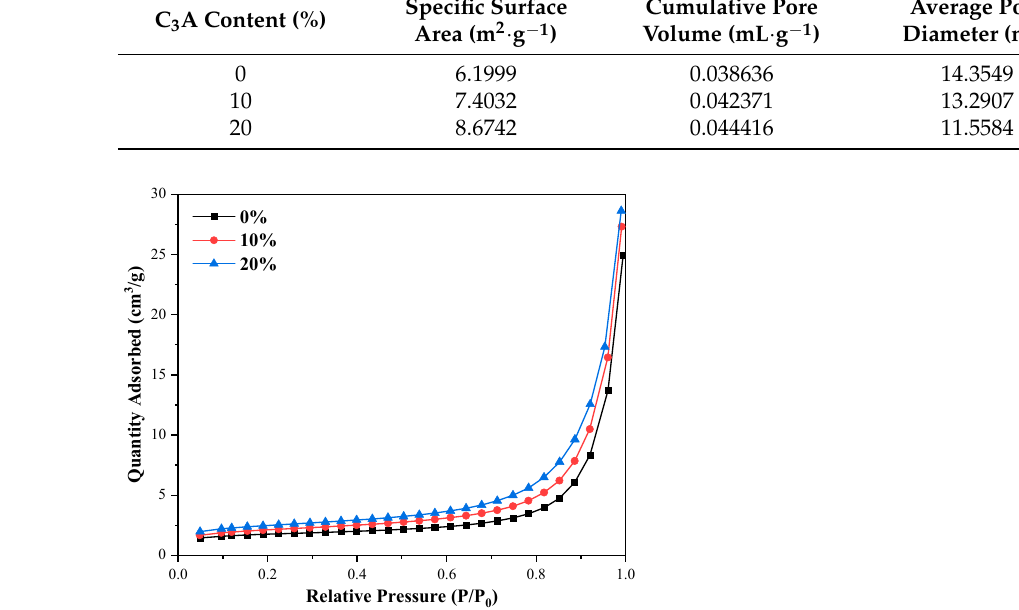
Table 5. Pore characterization of C 3 S-C 3 A paste.